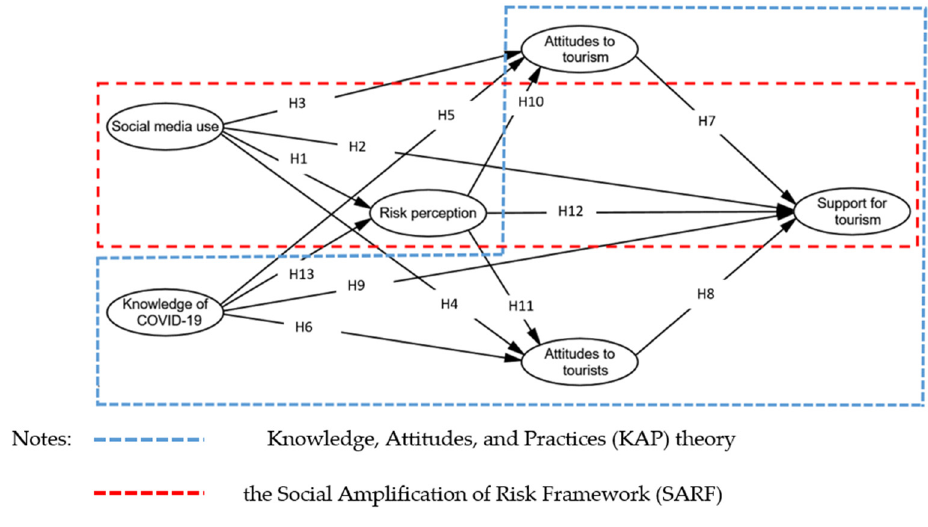
Figure 1. Theoretical model.